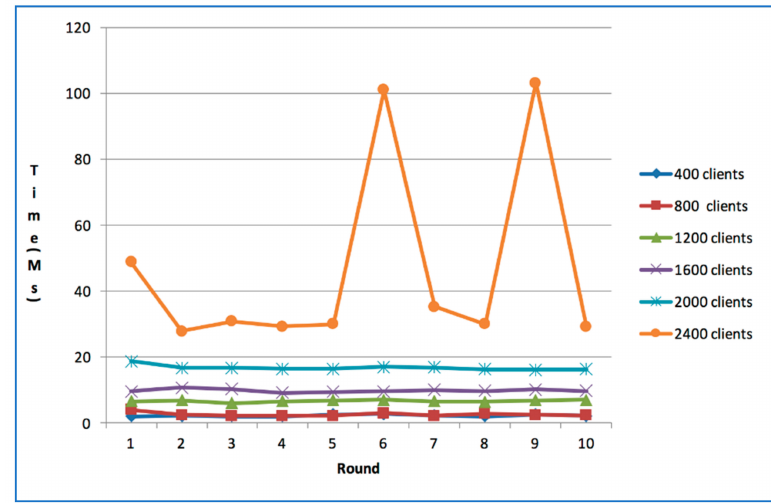
Figure 10. Network